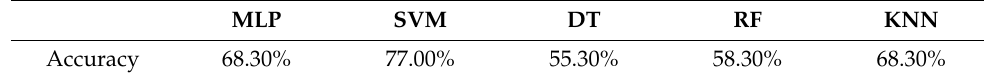
Table 7. Classification results for Dataset 04 (CVD/control).